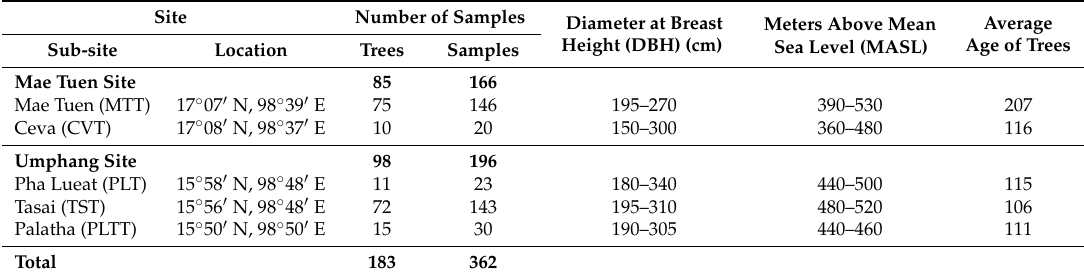
Table 1. Detail of sample data from Mae Tuen (MT) and Umphang (UP) in Tak province, northwestern Thailand.